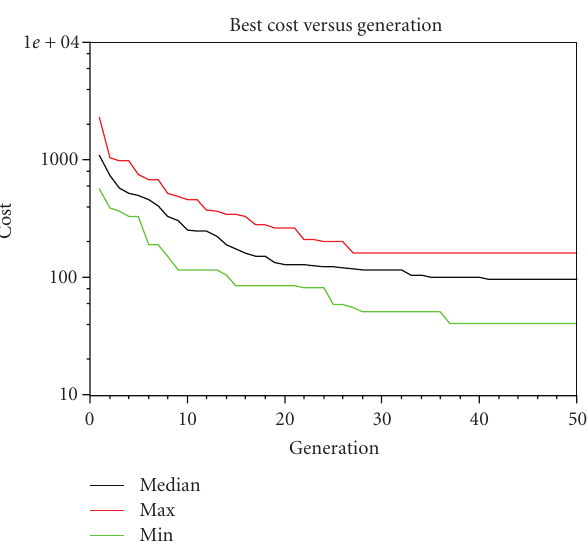
Figure 4: Best individual cost versus generation for single-branch GP